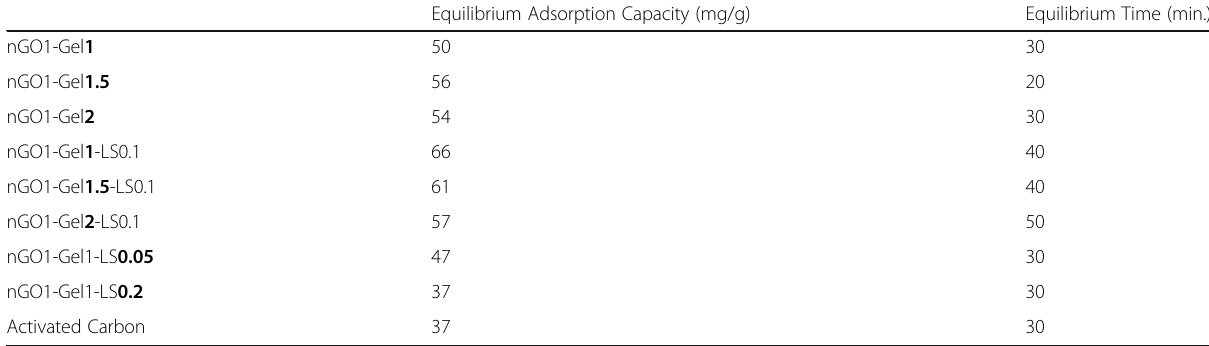
Table 2 Equilibrium Cu(II) adsorption capacities of non-functionalized and lignosulfonate (LS)-functionalized composites Equilibrium Adsorption Capacity (mg/g) Equilibrium Time (min.)